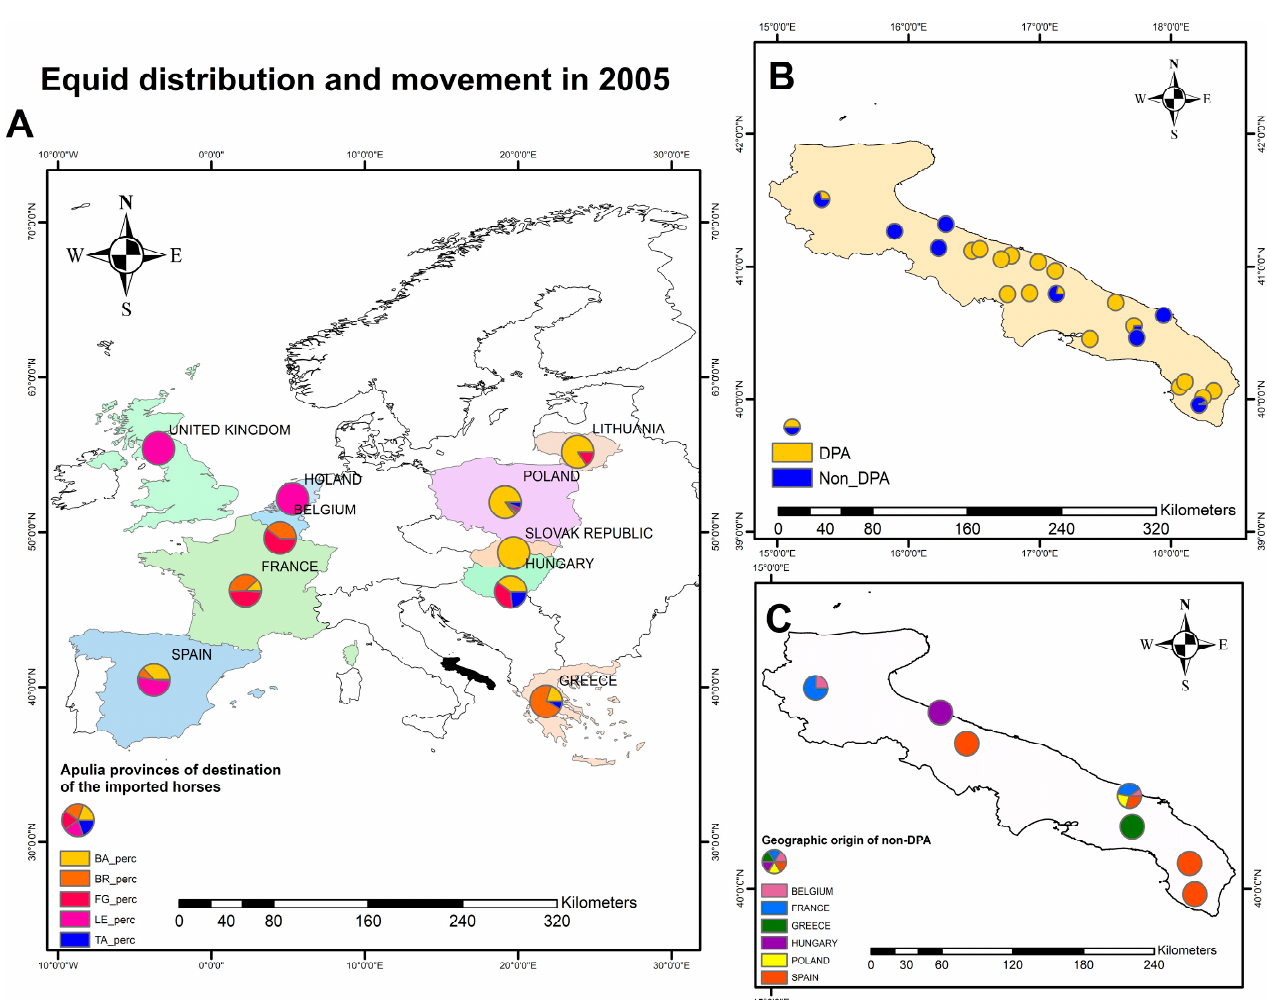
Figure 1. Fluxes of horses (countries of origin) imported in Apulia provinces (BA, Bari; BR, Brindisi; FG, Foggia; LE, Lecce; TA, Taranto) in 2005 ( A ); influxes of animals, based on their destinations (DPA, animals destined to slaughter; non-DPA, animals with other destination) in Apulia region ( B ); geographic provenience of non-DPA horse in November-December 2005 ( C ). Pie charts are not proportionate to the number of animals.